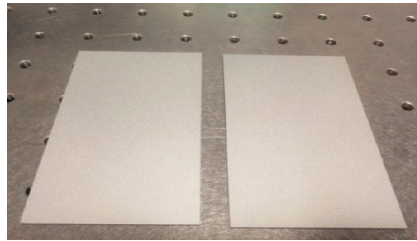
Figure 8. The rigid aluminum plates.